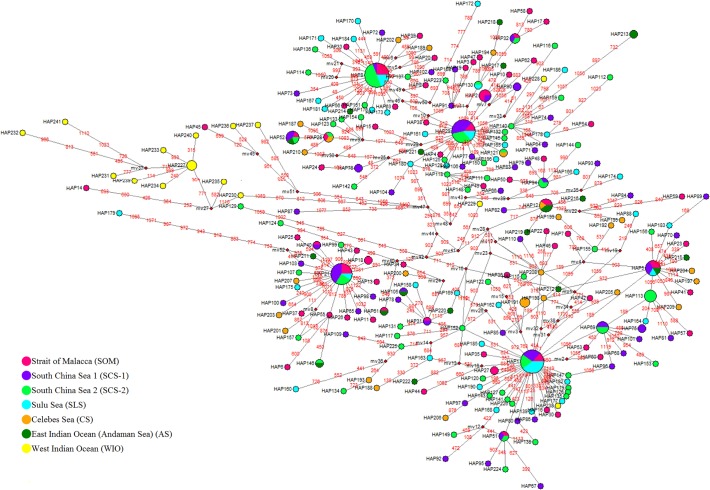
Minimum spanning network (MSN) inferred from complete mtDNA Cyt b.
Coloured close circles represent different regions (refer to legend). mv = median vectors. The red circle in the figure represents the BA tip haplotypes.